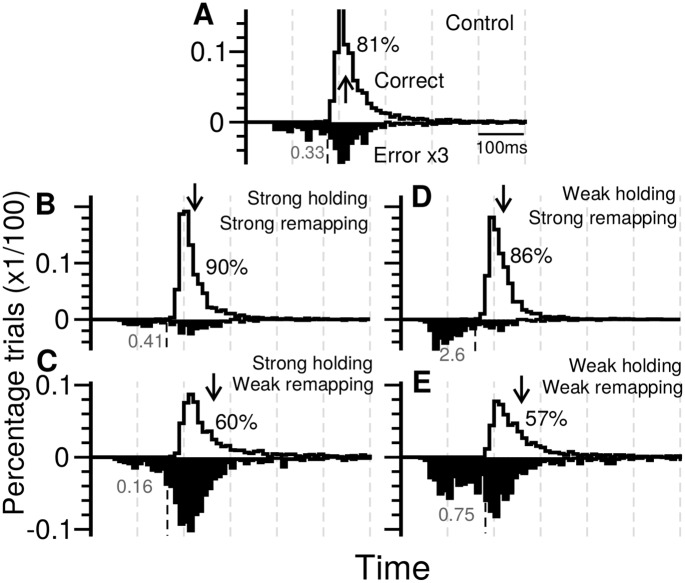
Gaze-holding control and remapping control both influence the behavioral outcome but with different effects.A. Reaction time distributions for the antisaccade trials with correct (white) and erroneous (black) responses in the Gap task. The distributions of erroneous responses in antisaccade have been magnified vertically by three-fold as in Fig 7. The black number to the right of the distribution of correct responses represents the percentage of correct trials. The grey number below the abscissa indicates the ratio between the numbers of fast and slow errors. B-E, same with A but with different strengths of gaze-holding control and remapping control. The strength of the remapping control affects the percentage correct, the mean reaction time and the ratio of fast/slow errors while the strength of the gaze-holding control mainly affects the ratio of fast/slow errors. Arrows indicate the mean RT of correct antisaccades in each panel.